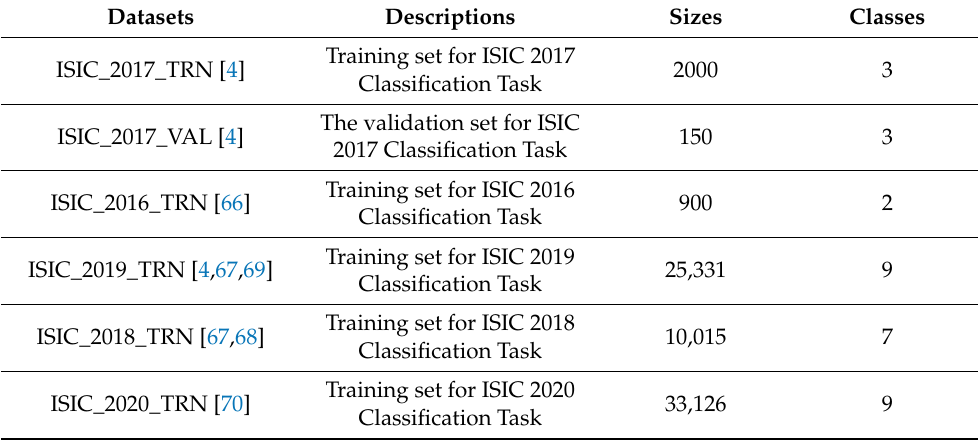
Table 1. Experimental image